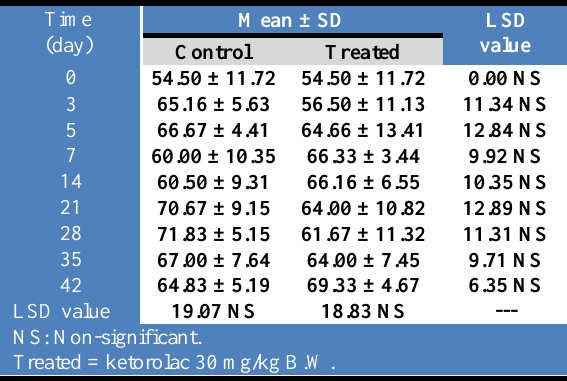
Table, 3: Shows PCV (%) in control and control and ketorolac treated rabbits..